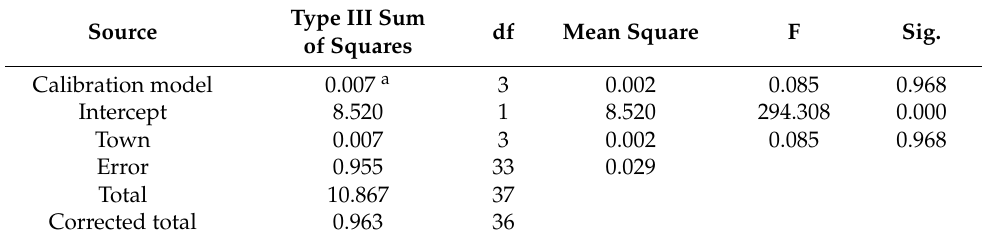
Table 11. One-way analysis of variance results table for primary